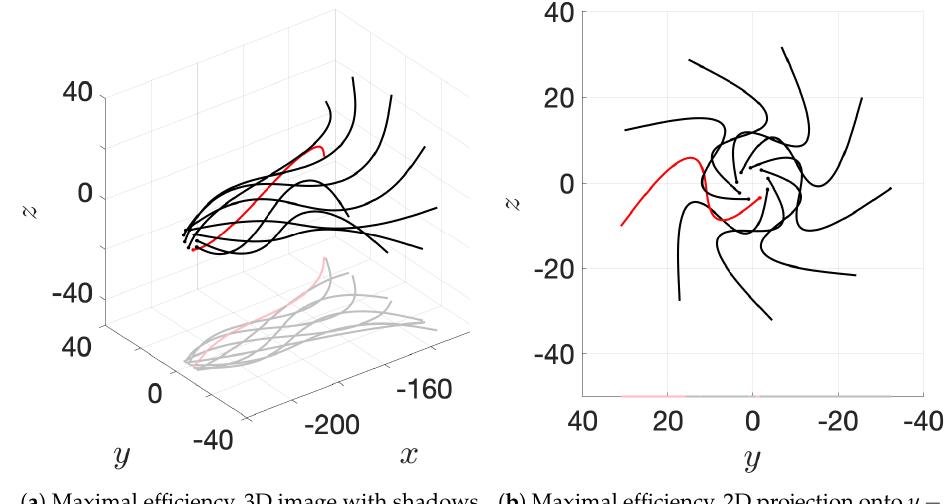
Figure 12. Snapshots of flagellar configurations for the cylindrical simulation from Figure 4a, for both maximal and minimal efficiencies observed. One flagellum is highlighted in red for visual emphasis of the geometry. See Supplemental Material Movie S1 for all configurations over